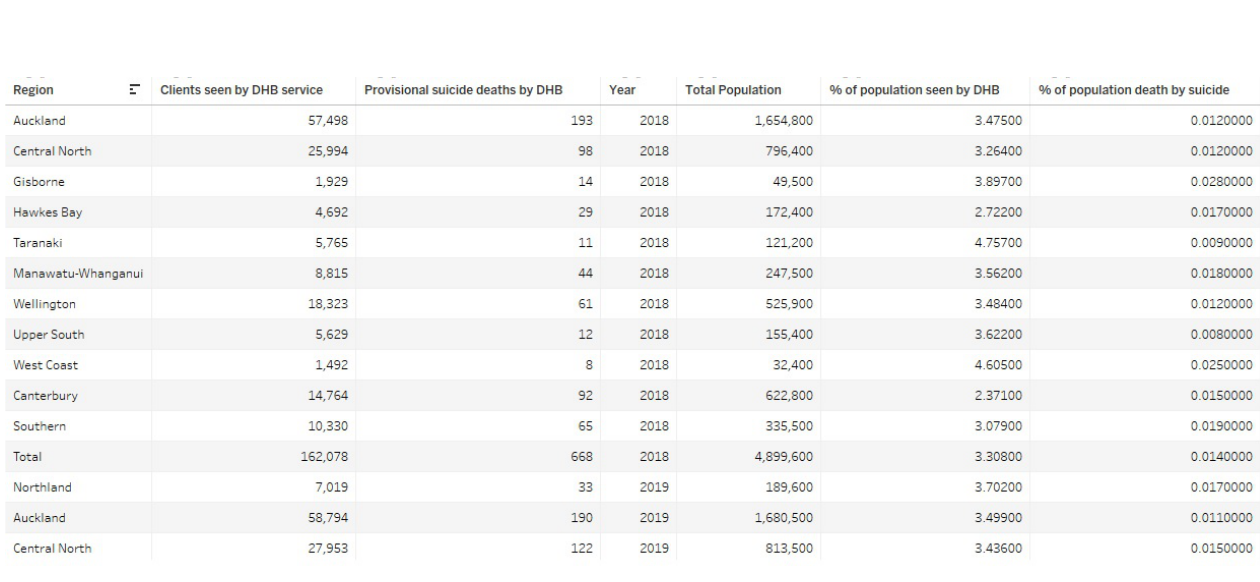
Figure 3. the snapshot of the mental health data of our